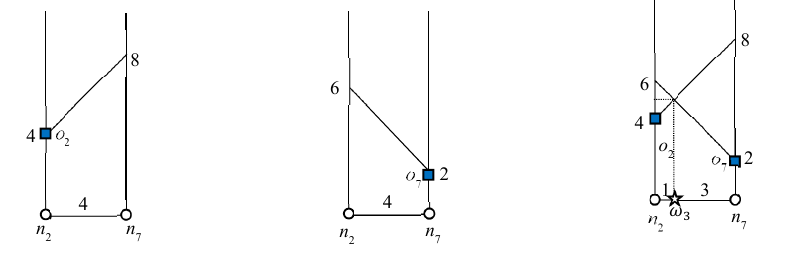
Figure 10. Determination of safe exit point ω 3 Table 4. Computation of safe exit points for o 1 .